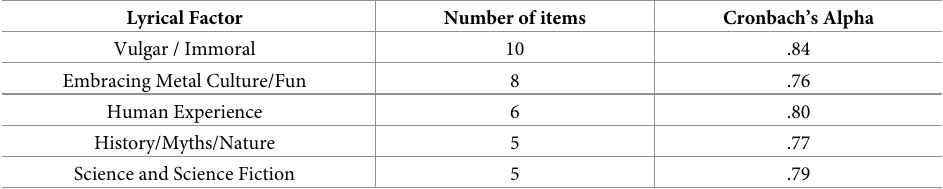
Table 3. Five factors representing lyrical subject